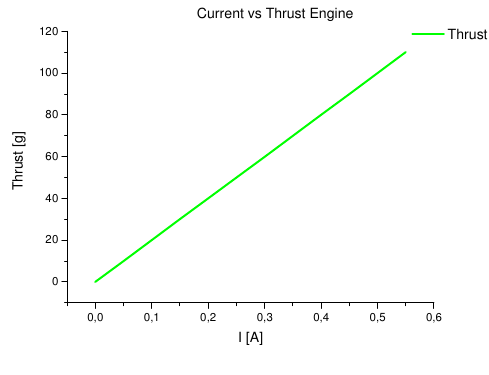
Figure 2: Curve shows the correlation between engine thrust and current battery